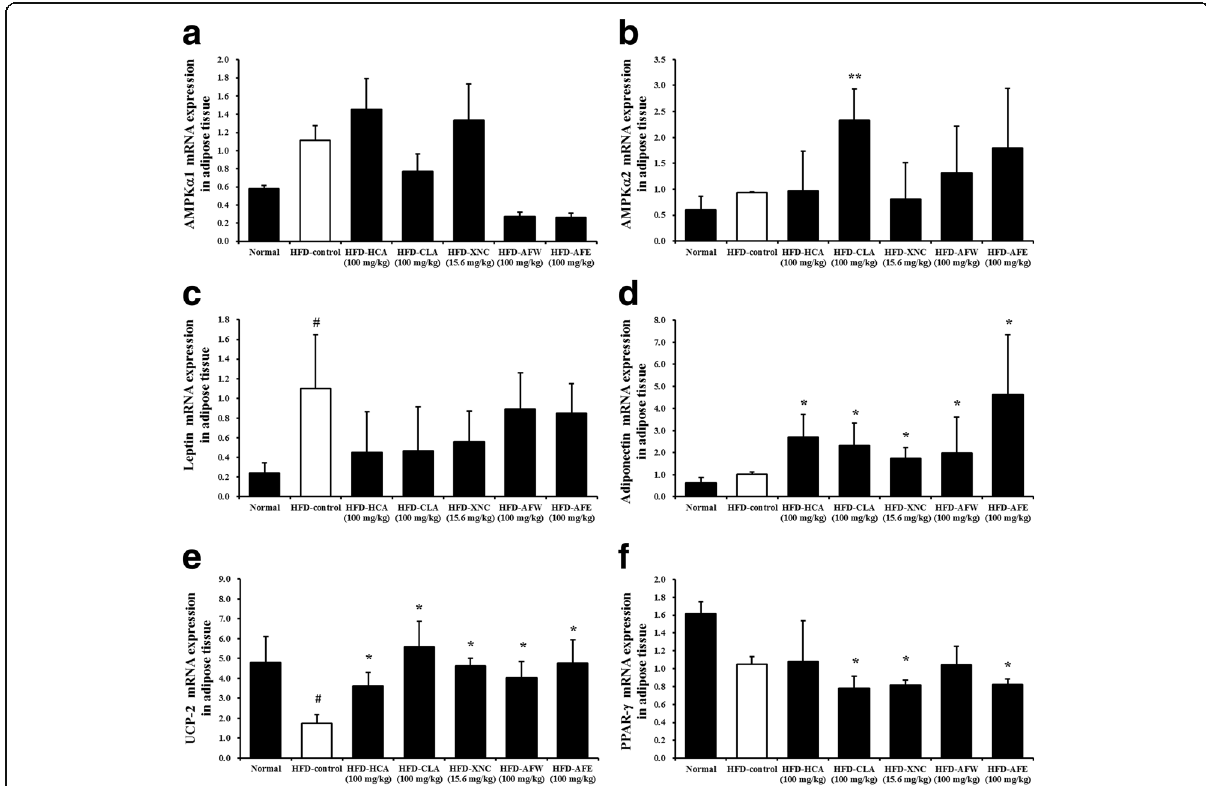
Fig. 7 Effect of 6-week treatment with Allium fistulosum aqueous extract (AFW) and A. fistulosum ethanolic extract (AFE) on gene expression in epididymal adipose tissue of high-fat diet (HFD)-induced obese mice. Expression levels of ( a ) adenosine monophosphate-activated protein kinase (AMPK) isoforms AMPK α 1, ( b ) AMPK α 2, ( c ) leptin, ( d ) adiponectin, ( e ) uncoupling protein 2 (UCP2), and ( f ) peroxisome proliferator-activated receptor gamma (PPAR- γ ),